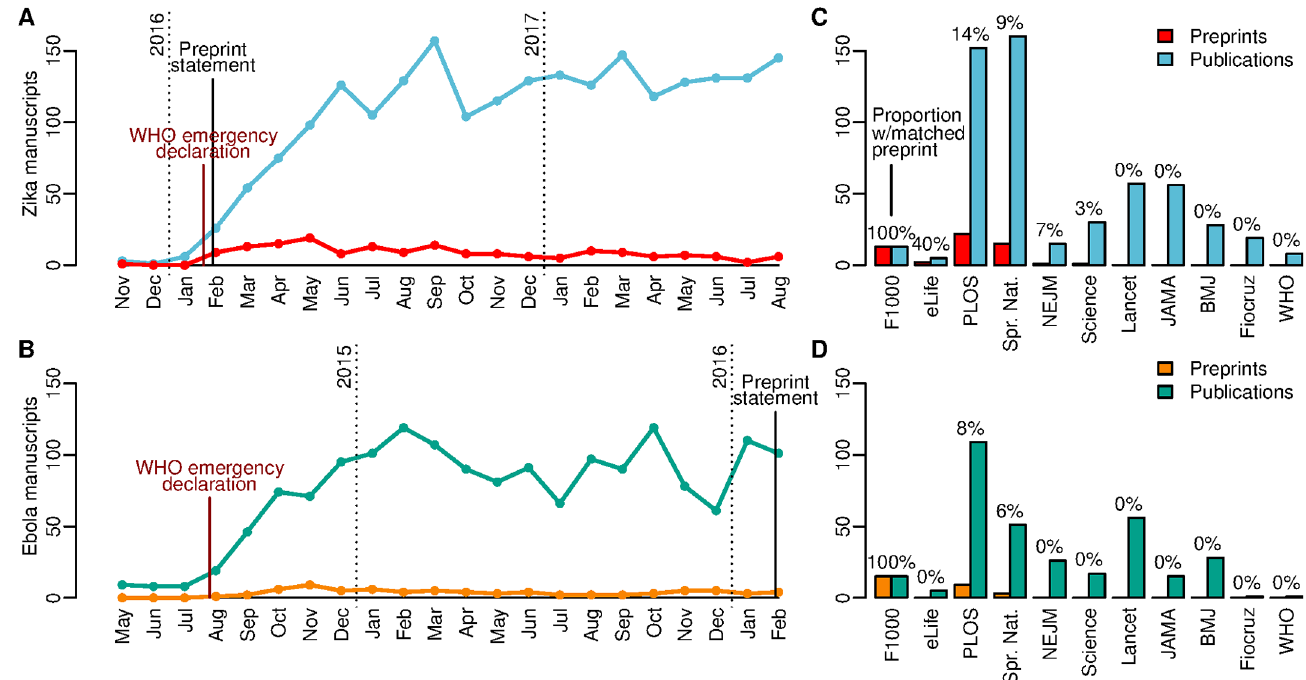
Fig 1. Zika and Ebola outbreak preprints and publications. Panels A (Zika) and B (Ebola) show the total number of newly posted preprints (arXiv, bioRxiv, F1000Research, PeerJ Preprints, or World Health Organization Zika Open) and journal articles (PubMed indexed) by month. Dates were the initial submission date for preprints and the journal publication date for PubMed (or the PubMed entry creation date if a specific journal publication date was not supplied). Panels C (Zika) and D (Ebola) show the number of preprints and publications by publisher for each of the publishers who were signatories to the data sharing statement ordered by the proportion of publications with a matched Zika preprint. Publisher abbreviations: BMJ, The British Medical Journal; F1000, Faculty of 1000; Fiocruz, Fundac¸ ã o Oswaldo Cruz; JAMA, The Journal of the American Medical Association Network; NEJM, The New England Journal of Medicine; PLOS, Public Library of Science; Science, Science Journals; Spr. Nat., Springer Nature; WHO, Bulletin of the World Health